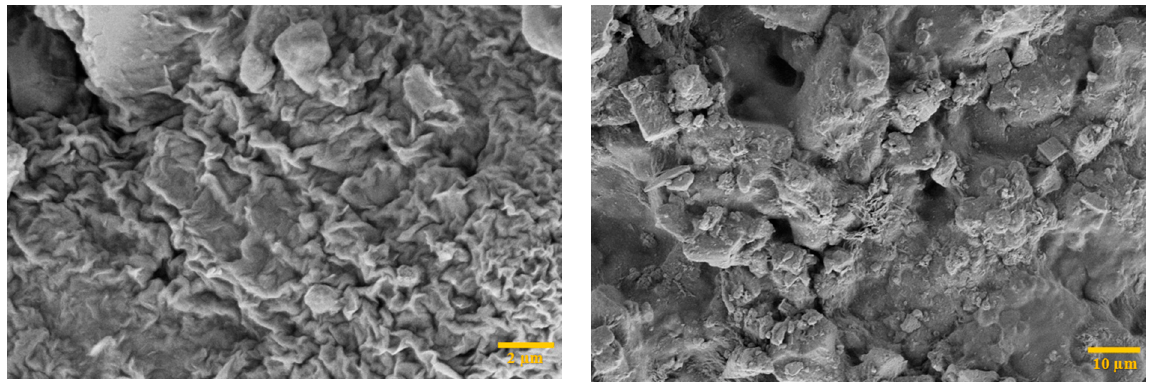
Figure 9. FESEM images of filtercakes of optimized samples